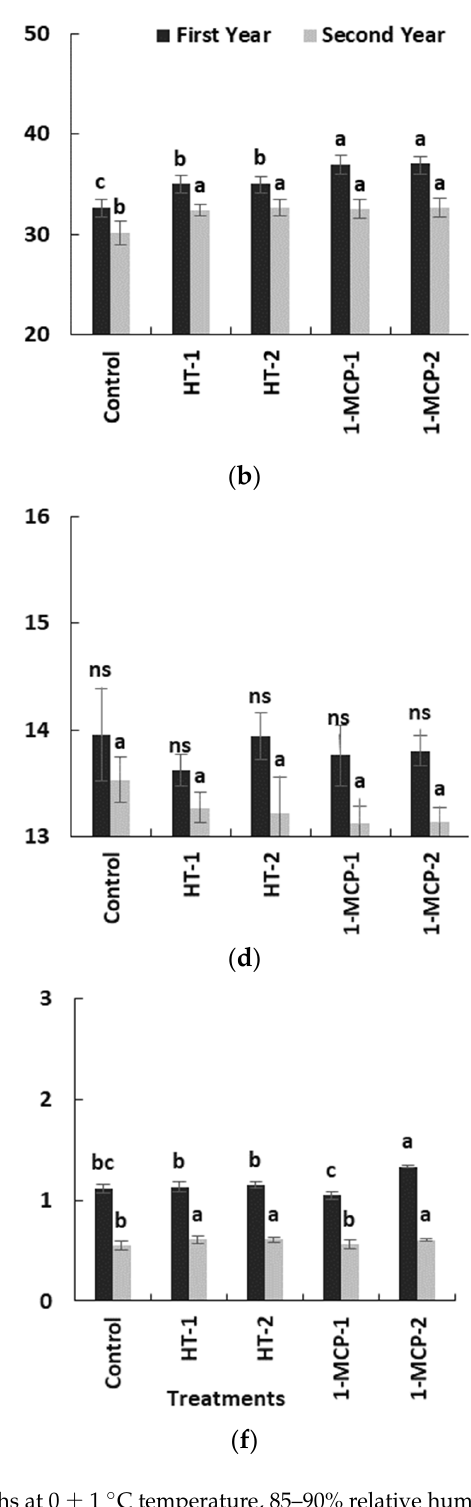
Figure 5. The effect of storage period of 6 months at 0 ± 1 ◦ C temperature, 85–90% relative humidity and regular air conditions ( a , c , e ); and the effect of different postharvest treatments ( b , d , f ) on flesh firmness, soluble solids content and titratable acidity of quince fruit during long-term cold storage. Control—without postharvest treatment; HT-1—Hot water treatment at 50 ± 1 ◦ C for 3 min; HT-2—Hot water treatment at 50 ± 1 ◦ C for 5 min; 1-MCP-1—300 ppb 1-methylcyclopropane (1-MCP) treatment at 12 ◦ C for 20 h; 1-MCP-2—1000 ppb 1-MCP treatment at 12 ◦ C for 20 h. Vertical lines are the standard error of means. Different letters are significantly different, according to Tukey test, at p ≤ 0.05 significance level; ns—not significant at p >